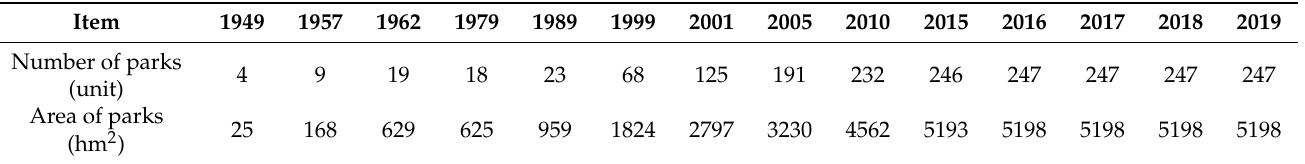
Table 1. The amount of park construction of Guangzhou in the main